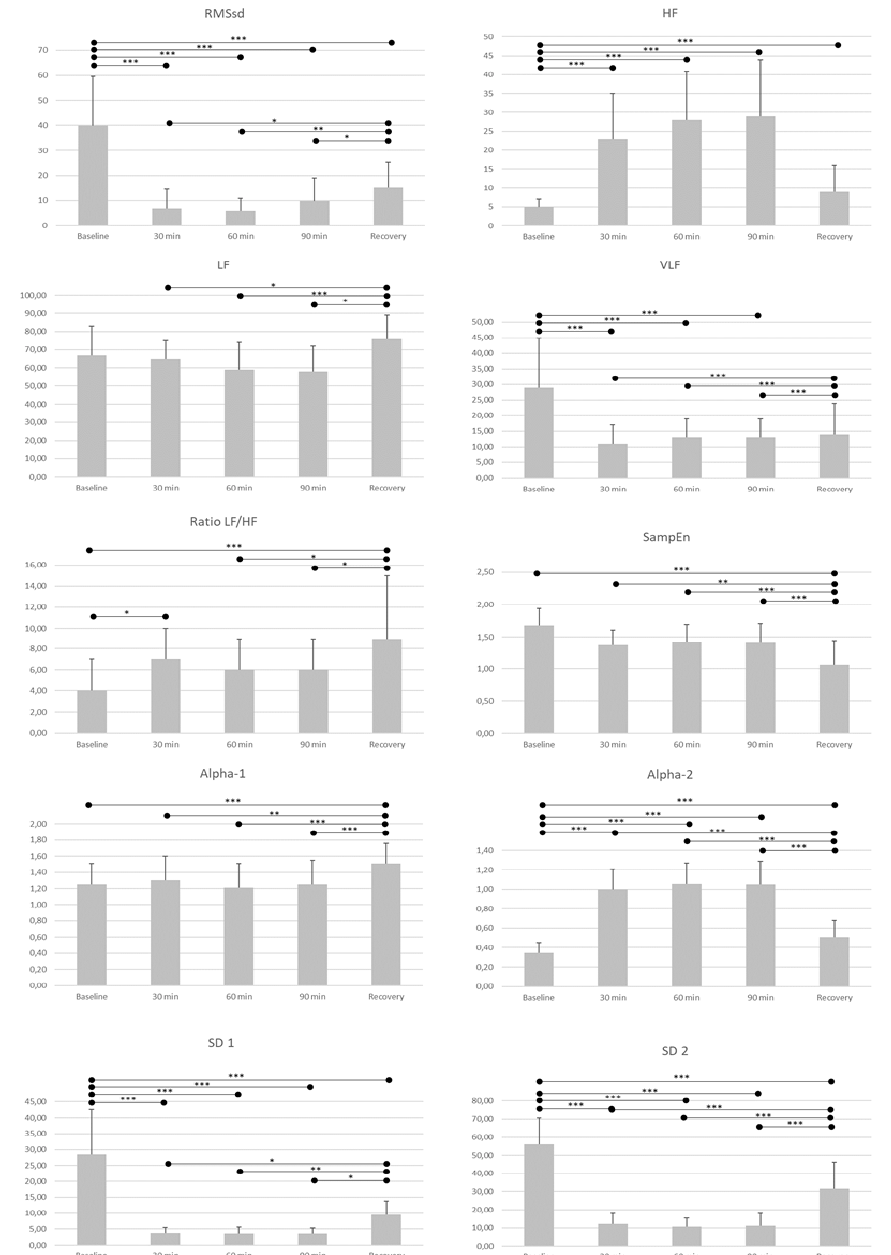
Figure 1. Changes of the time-domain variable (RMSsd—(ms)), frequency-domain variable (HF, LF, VLF—(Hz) and LF/HF ratio), and the non-linear measures (Alpha-1, Alpha-2, SampEn, SD1 and SD2 (ms)), during the protocol: at baseline, after 30 min of the game, after 60 min of the game, after 90 min of the game, and during recovery. p < 0.05 *, p < 0.01 **, p < 0.001 ***. RMSSD: the square root of the mean of the squares of the successive differences of the interval RR; Alpha-1: Short-term fluctuation of the detrended fluctuation analysis; Alpha-2: Long-term fluctuation of the detrended fluctuation analysis; SD1: Dispersion, standard deviation of points perpendicular to the axis of line-of-identity in the Poincaré plot; SD2: Dispersion, standard deviation of points along the axis of line-of-identity in the Poincaré plot; LF: Low frequency; HF: High frequency; VLF: Very low frequency; LF/HF: Low frequency (LF) ratio (ms2)/High frequency (HF) (ms2).